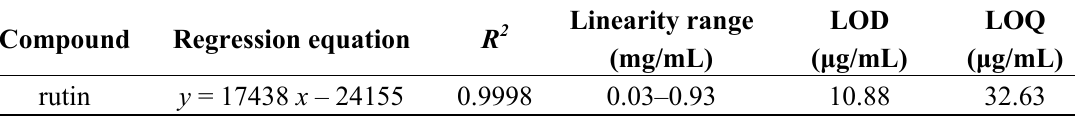
Table 1. Linear regression equation, correlation coefficient and linearity of